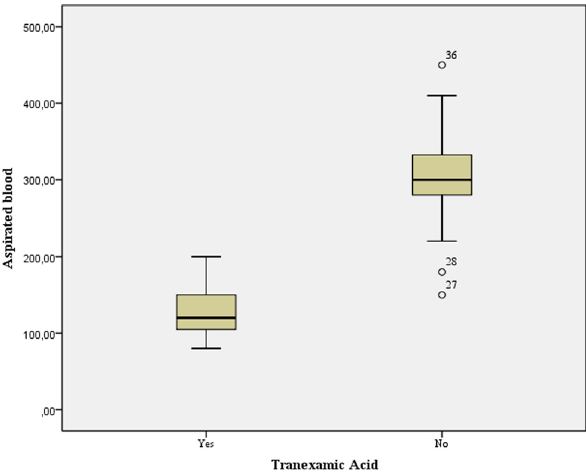
Figure 1: Blood aspiration in the analyzed groups.